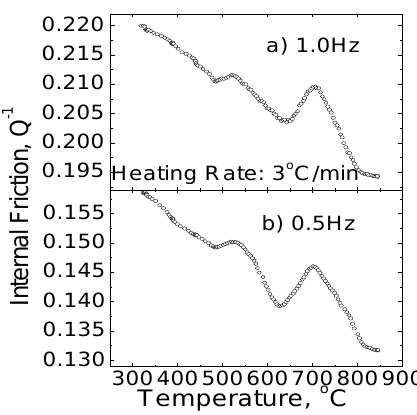
Figure 3. Q −1 - T behavior of the melt In-Sn80. ( a ) at frequency 1.0 Hz; ( b ) at frequency 0.5